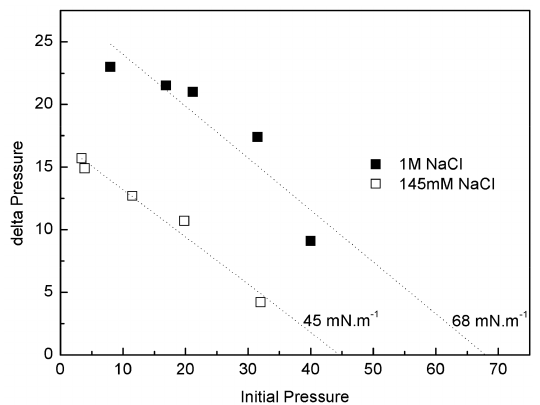
Figure 10. Penetration of IBU-Na into DOPE. ( ∆ π ) max of IBU-Na versus initial surface pressure of DOPE monolayers with 145 mM (empty squares) and 1 M (full squares) NaCl.